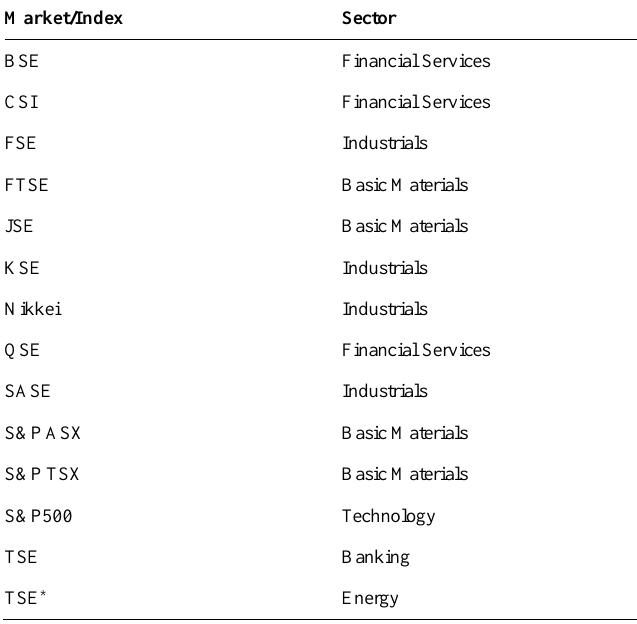
Table 16. The main information transmitter sectors, before COVID-19